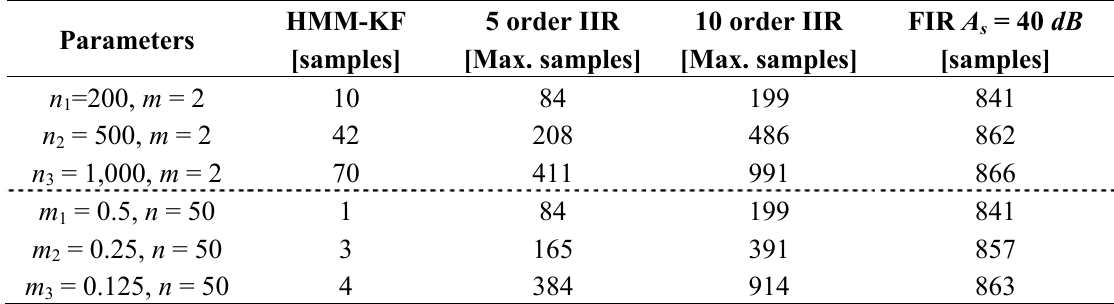
Table 7. Comparison of the time delay (in samples) of the z axis angular rate using the three